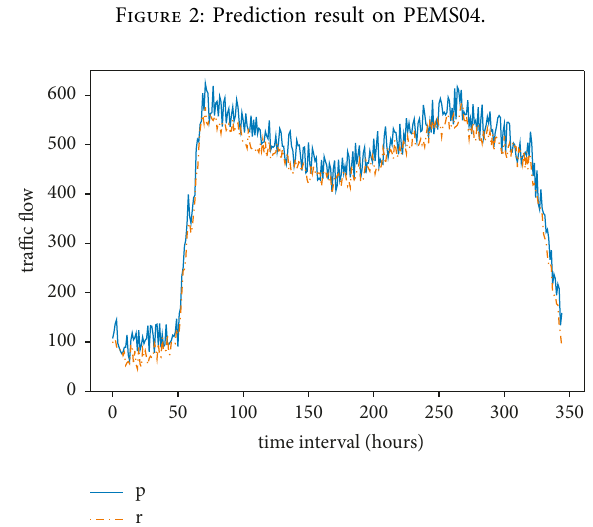
Figure 3: Prediction result on